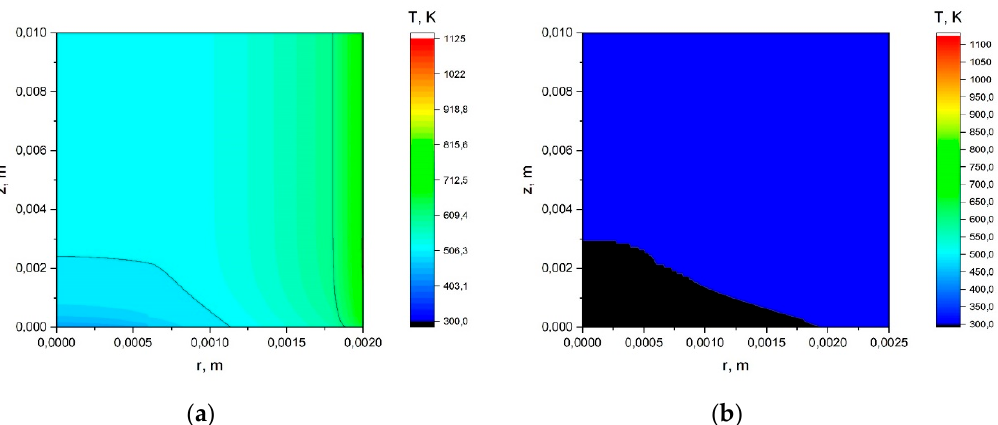
Figure A5. Temperature distribution in the stem of a herbaceous plant: R = 0.002 m, t = 6 s, q = 30 kW/m 2 ( a ); R = 0.0025 m, t = 0.5 s, q = 0.5 kW/m 2 ( b ).